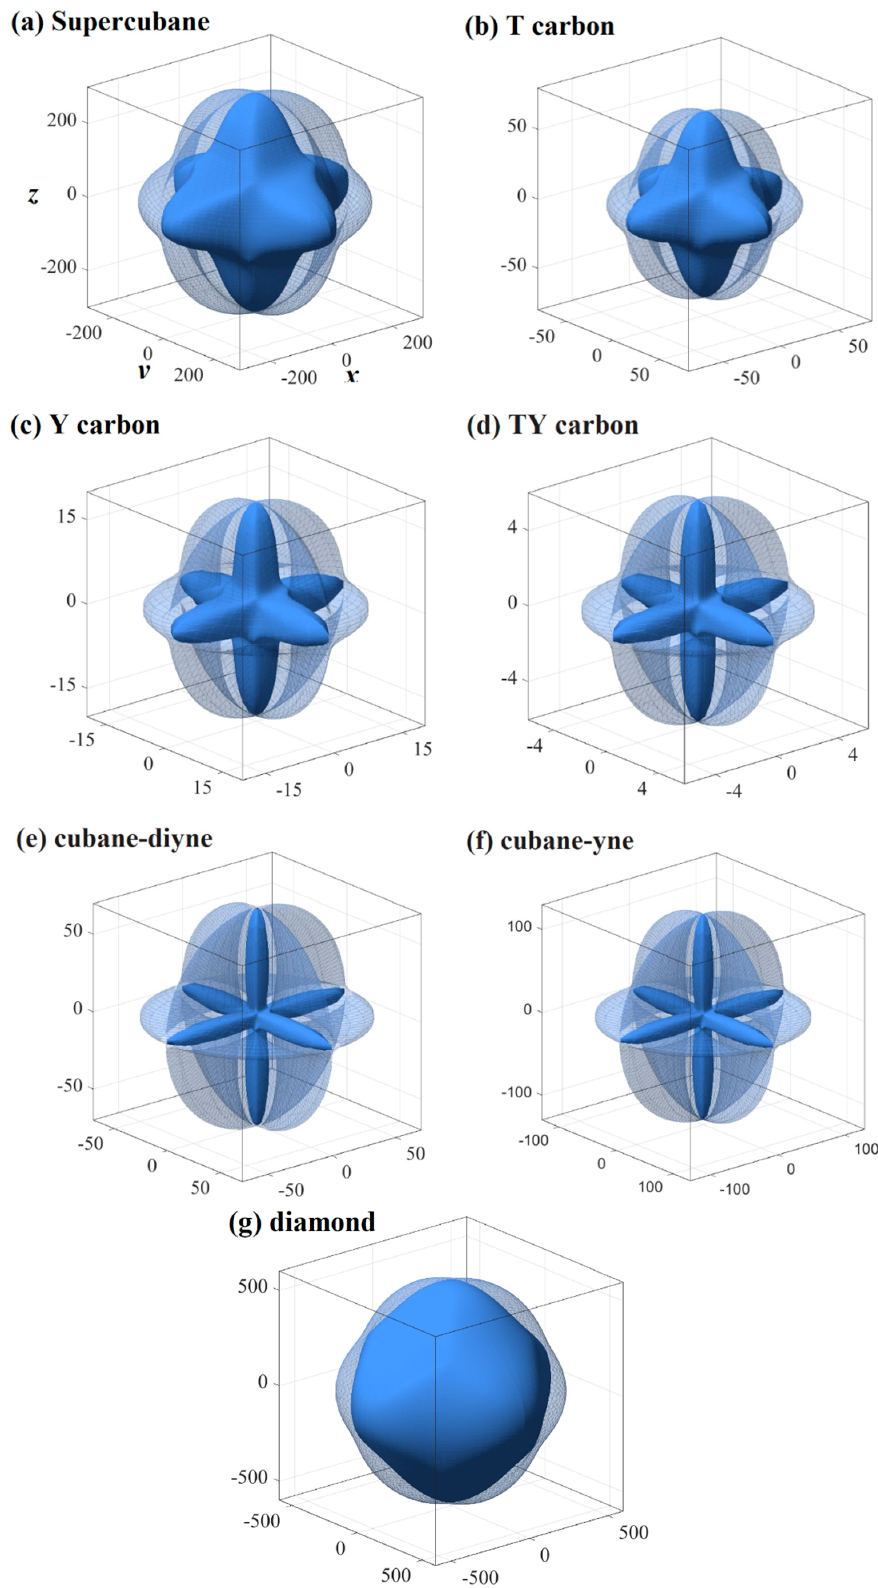
Figure 4. Three-dimensional contour plots of the shear modulus for supercubane ( a ), T carbon ( b ), Y carbon ( c ), TY carbon ( d ), cubane-diyne ( e ), cubane-diyne ( f ), and diamond ( g ).